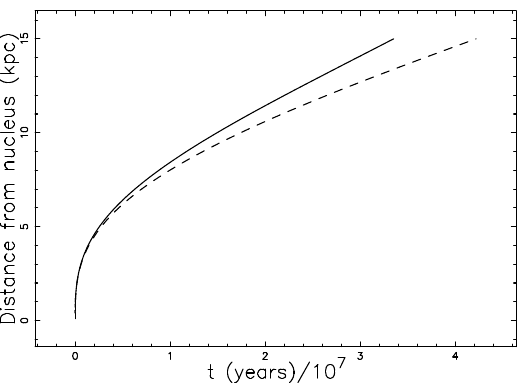
Figure 9. Numerical relativistic solution as given by Equation (51) (full line) and the solution with back-reaction, i.e., to second order, (dashed line), with parameters as in Table 2 and (cid:101) = 2.0 × 10 − 5